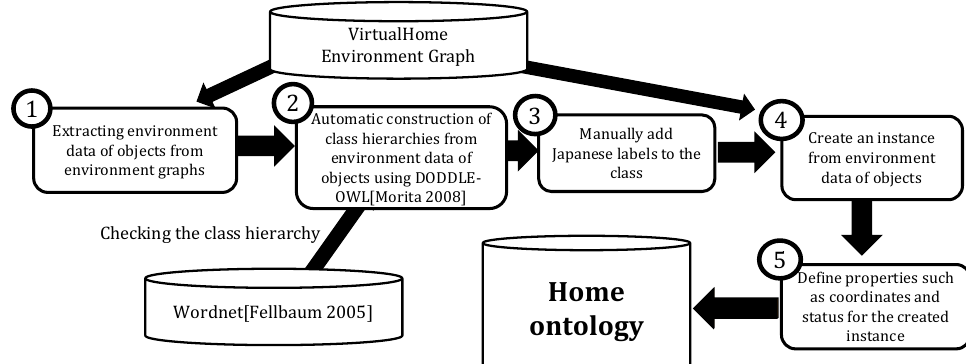
Figure 10. Home ontology construction